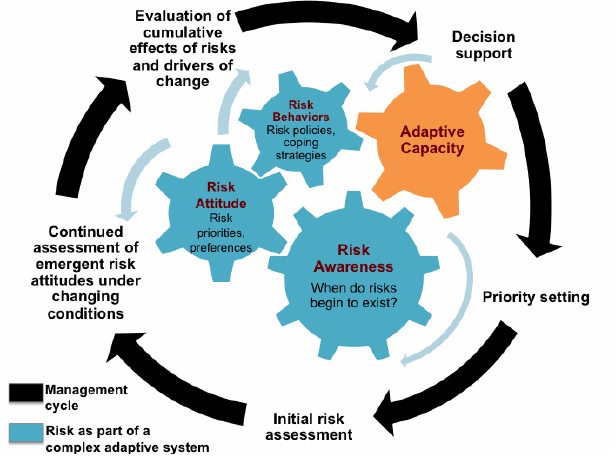
Fig. 1 . Risk and adaptive capacity as parts of a complex adaptive social